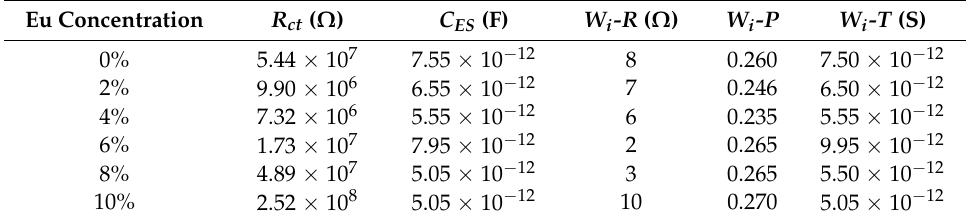
Figure 4. The impedance plots of YF 3 :Eu 3+ nanocrystals. The DC polarization voltage for the impedance plots (V DC ) is 0 V. The insert is the equivalent circuits, R ct is the ion transfer resistance, W i is Warburg element, C ES is the capacitance between the sample and electrode. Table 1. The fitting parameters of the equivalent circuit for the impedance plots.